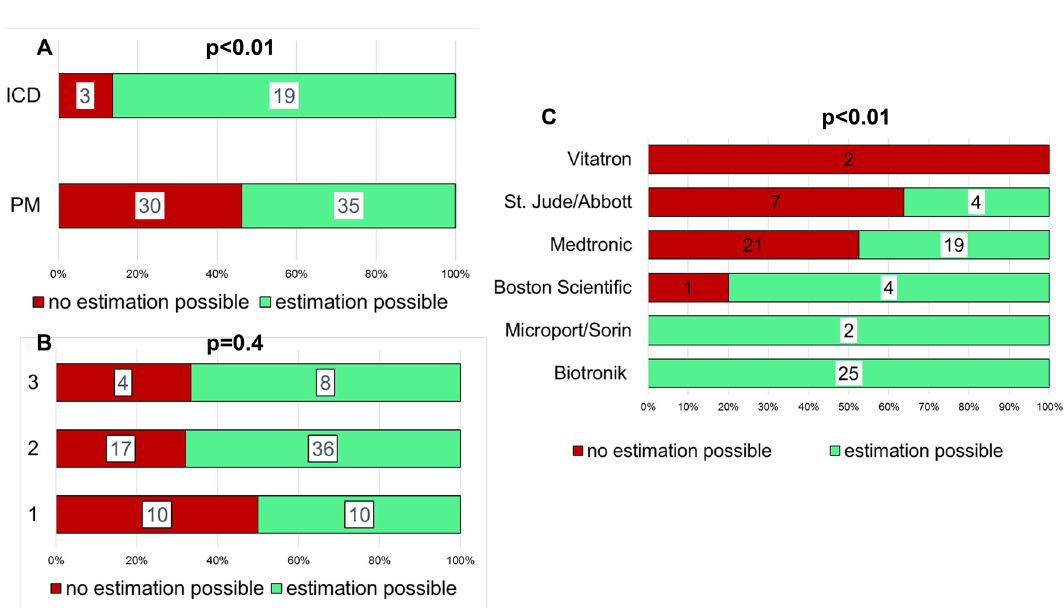
Figure 4. Differences in success rates of determination of time of death. ( A ): Determination of time of death was significantly more frequent in ICD devices ( p < 0.01). ( B ): The number of leads is not significant with respect to the determination of time of death. ( C ): Relevant differences exist depending on CIED manufacturer ( p <